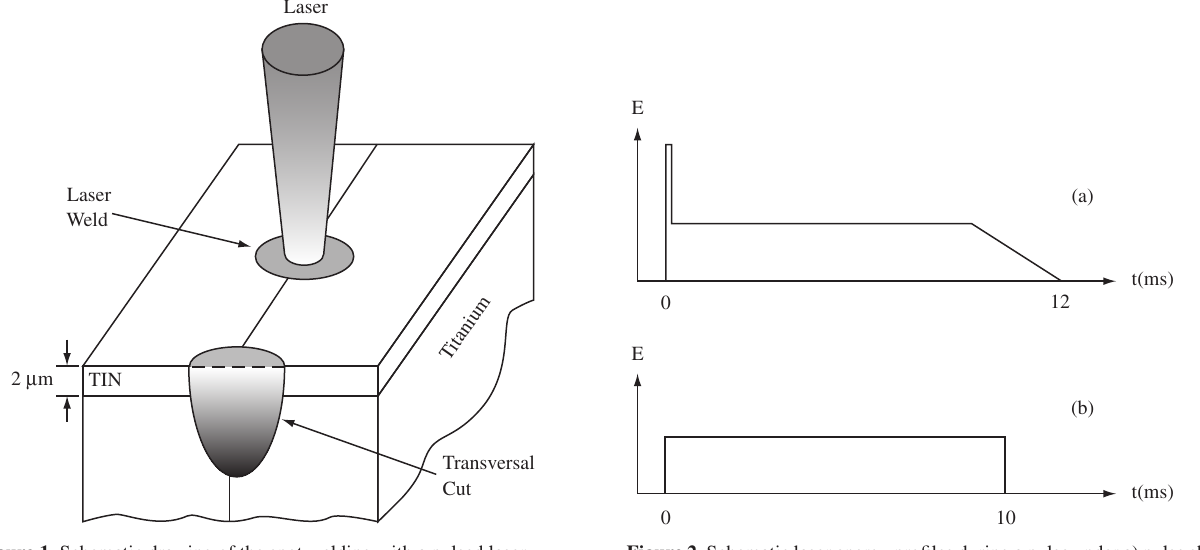
Figure 1. Schematic drawing of the spot welding with a pulsed laser. Figure 2. Schematic laser energy profiles during a pulse under a) pulse shap- ing; and b) normal conditions.